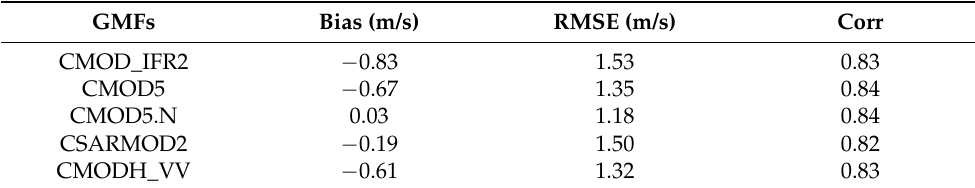
Table 2. Comparison of wind speed retrieval results of the GF3-02 VV polarization data based on each GMF model and ERA5 wind data. GMFs Bias (m/s) RMSE (m/s) Corr CMOD_IFR2 −